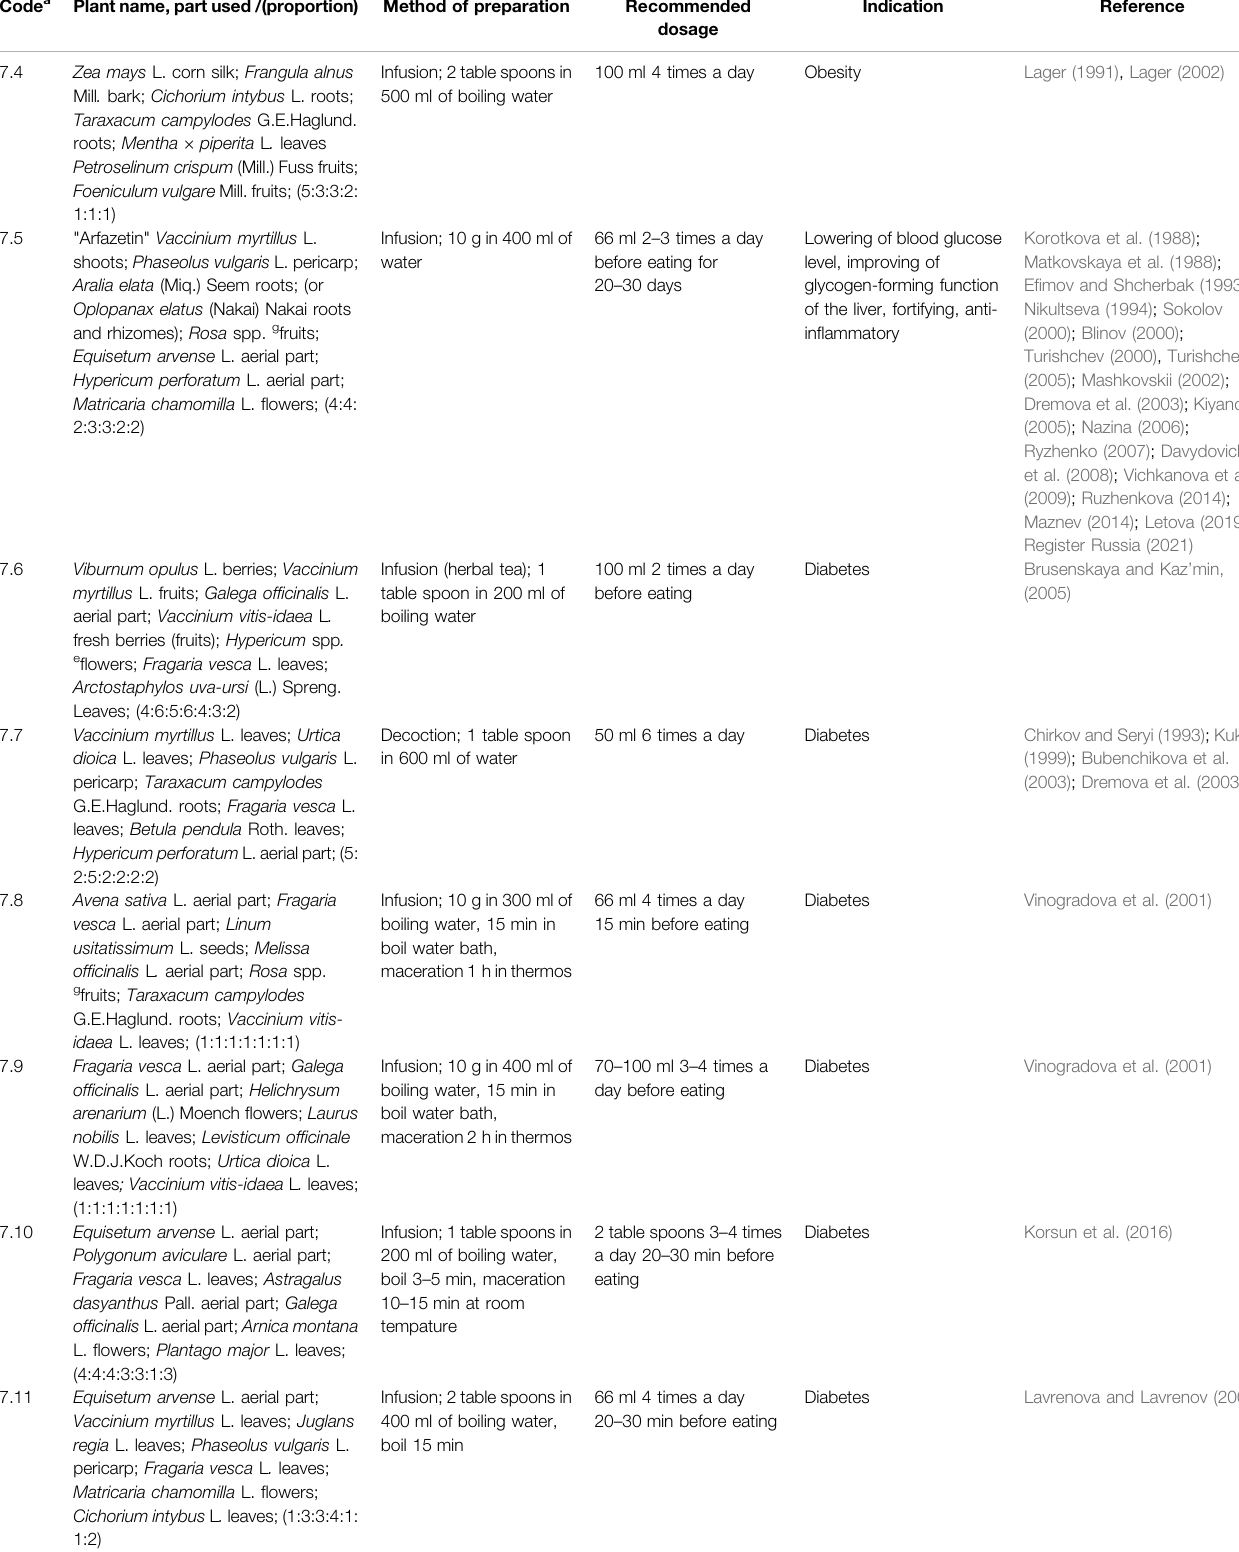
TABLE 1 | ( Continued ) The list of medical species used for the management of diabetes and related disorders in Russia. Code a Plant name, part used /(proportion) Method of preparation Recommended